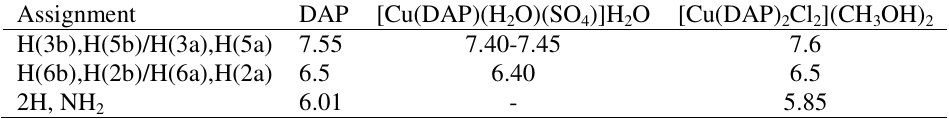
Figure 1. Molecular Structure of 4, 4-diaminodiphenylsulphone. Table 2. 1 HNMR for δ (DAP) and its complexes.